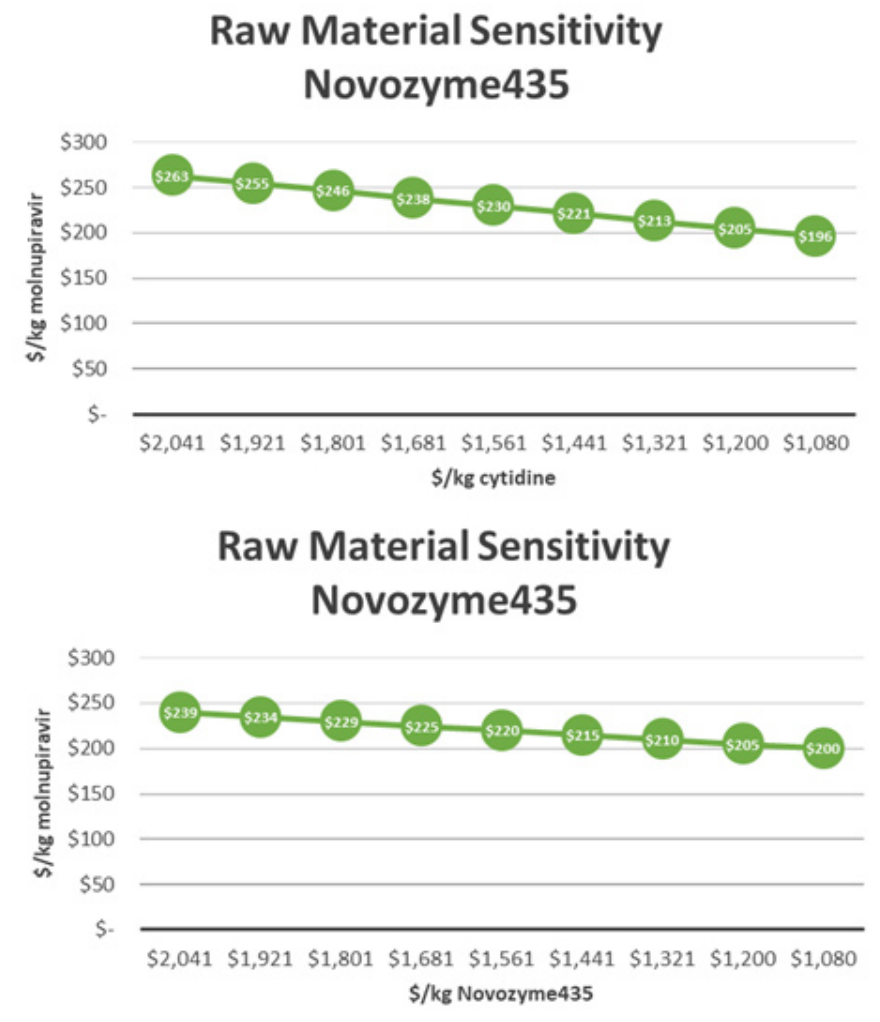
Figure 6. M4ALL Biocatalytic Route B from Cytidine sensitivity analysis for (a) cytidine and (b) Novozyme